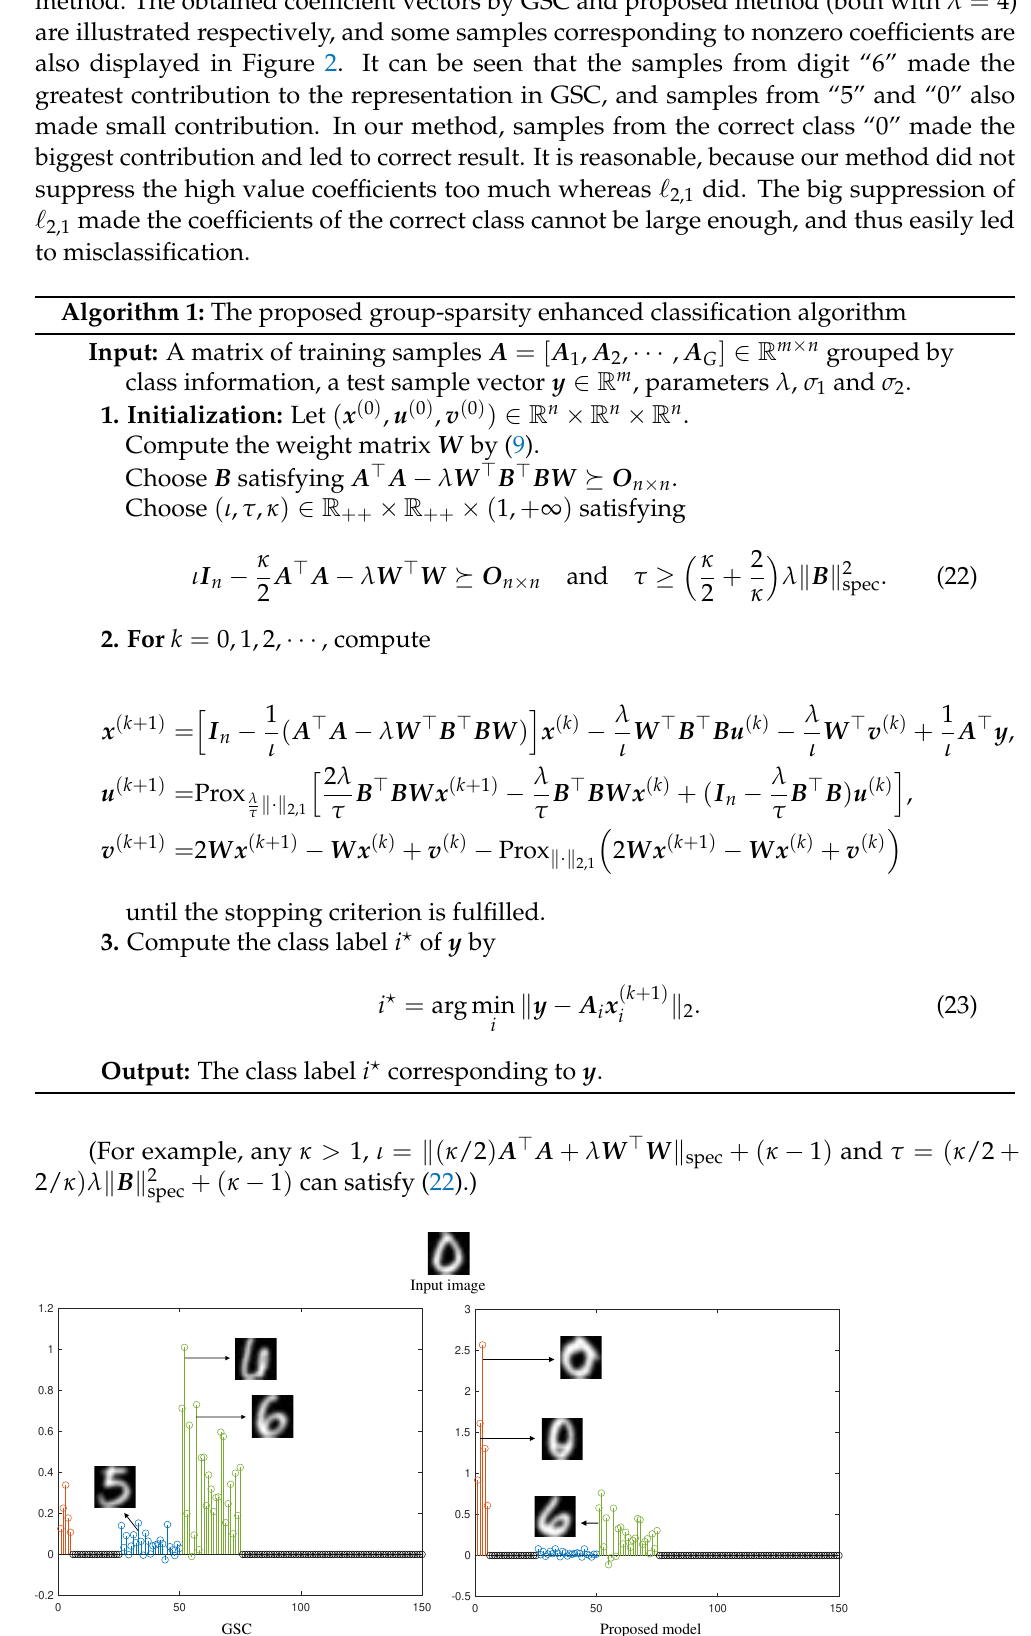
Figure 2. Estimated sparse coefficients ˆ x by GSC and proposed method